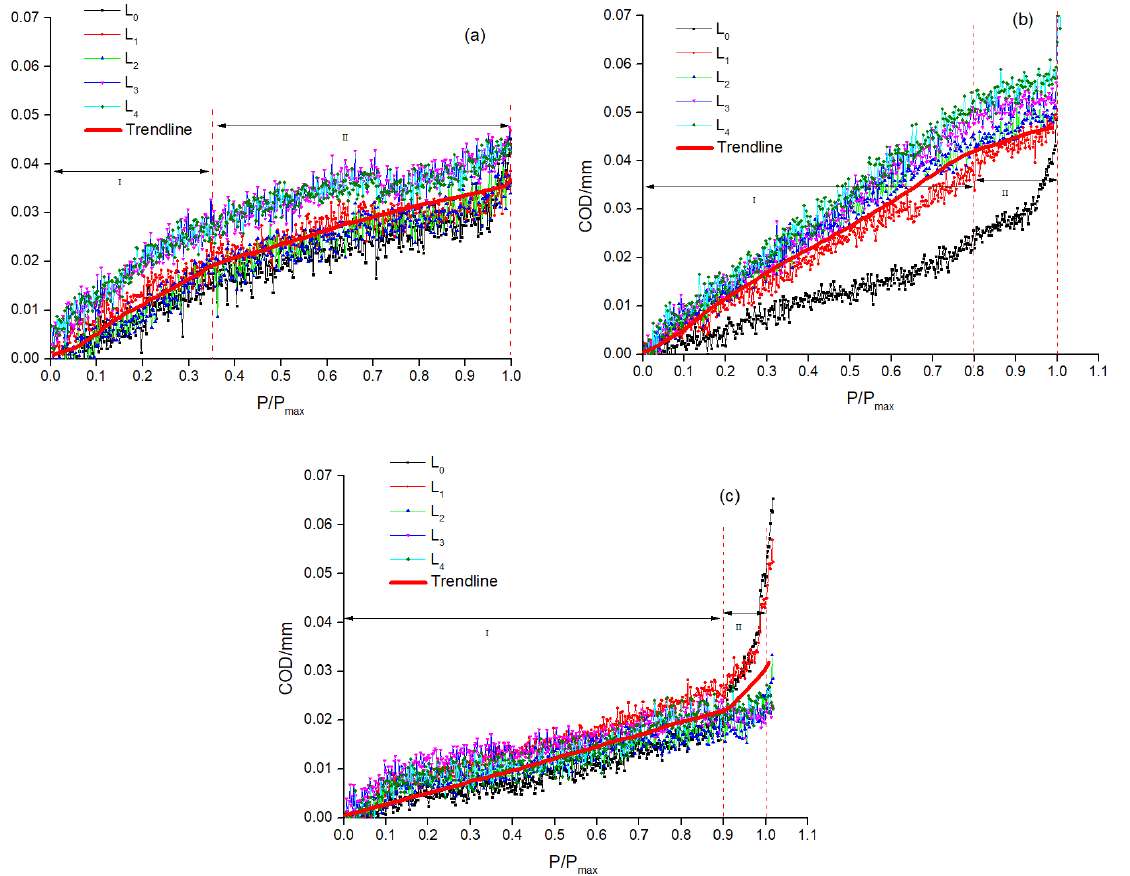
Figure 11. The relationships between the COD and P/P max of specimens ( a ) C0, ( b ) CAR, and ( c ) CARF.